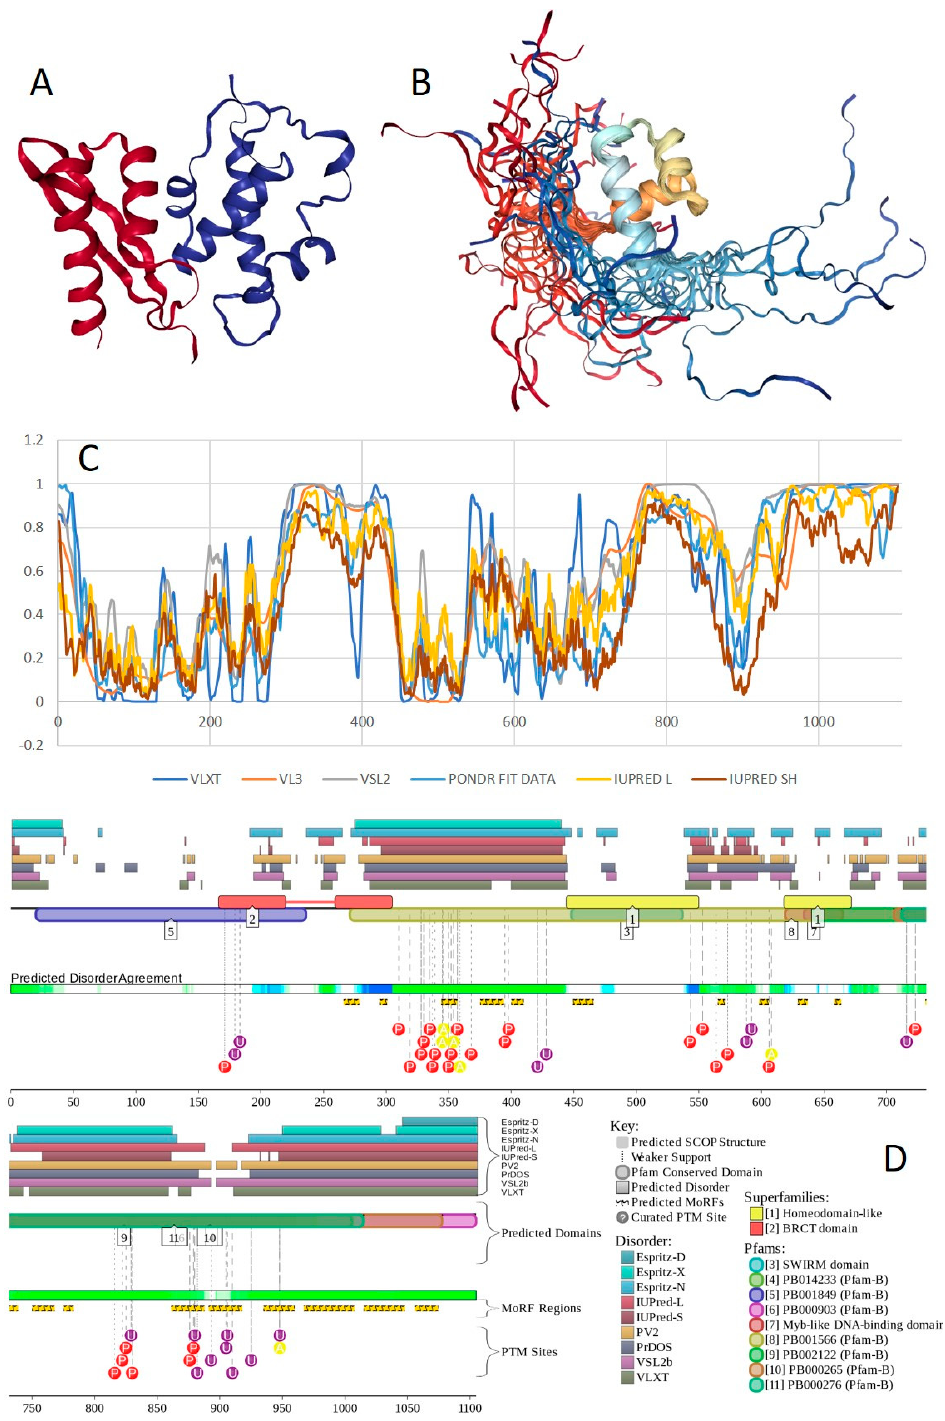
Figure 7. Structural organization of the human BAF155 protein. ( A ) X-ray crystal structure of SWIRM domain (residues 446–540, blue structure) in a complex with the repeat 1 (RPT1) domain of BAF47 (residues 183–289, red structure; PDB ID: 5GJK). ( B ) NMR solution structure of the SANT domain (residues 610–675; PDB ID: 1RYU). ( C ) Intrinsic disorder profile of human BAF155 generated by six commonly used predictors of intrinsic disorder (PONDR ® VLXT, PONDR ® VL3, PONDR ® VSL2, PONDR ® FIT, IUPred_short, and IUPred_long). ( D ) D 2 P 2 functional disorder profile of the human BAF155 protein (UniProt ID: Q92922). 2.5. BAF170 (PPID = 63.1%)